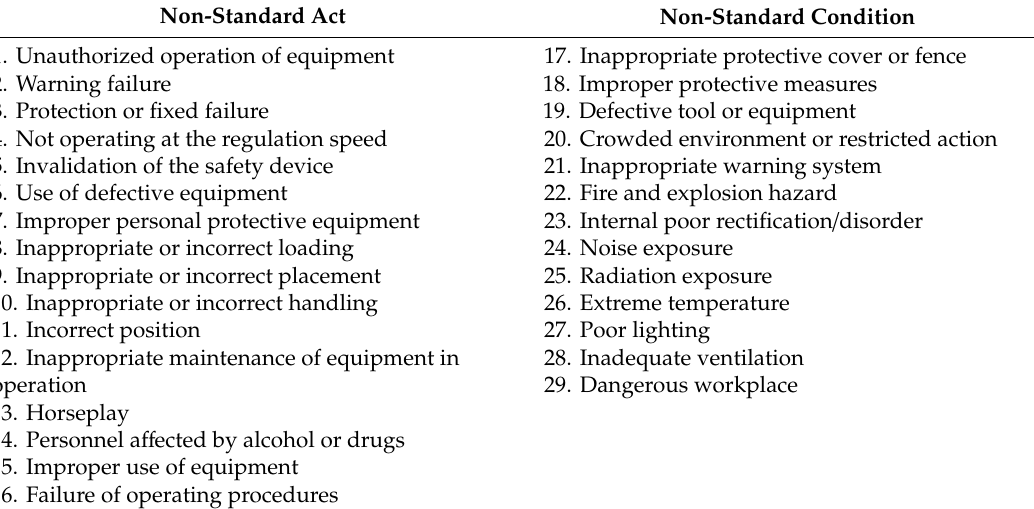
Figure 3. The ILCI loss causation model. Table 2. Checklist for direct causes defined using SCAT.